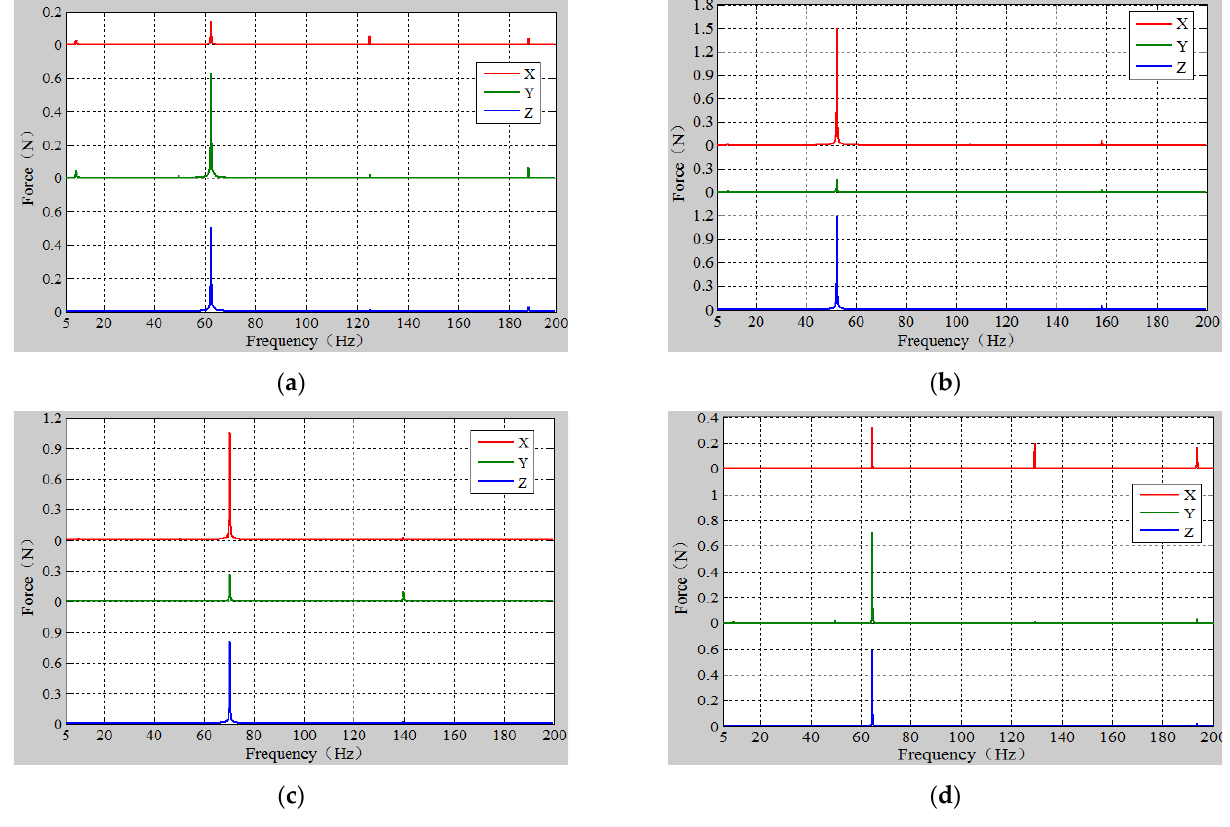
Figure 4. Frequency domain excitation force data of each motor within 5–200 Hz: ( a ) I1; ( b ) I2; ( c ) I3; ( d ) I4.